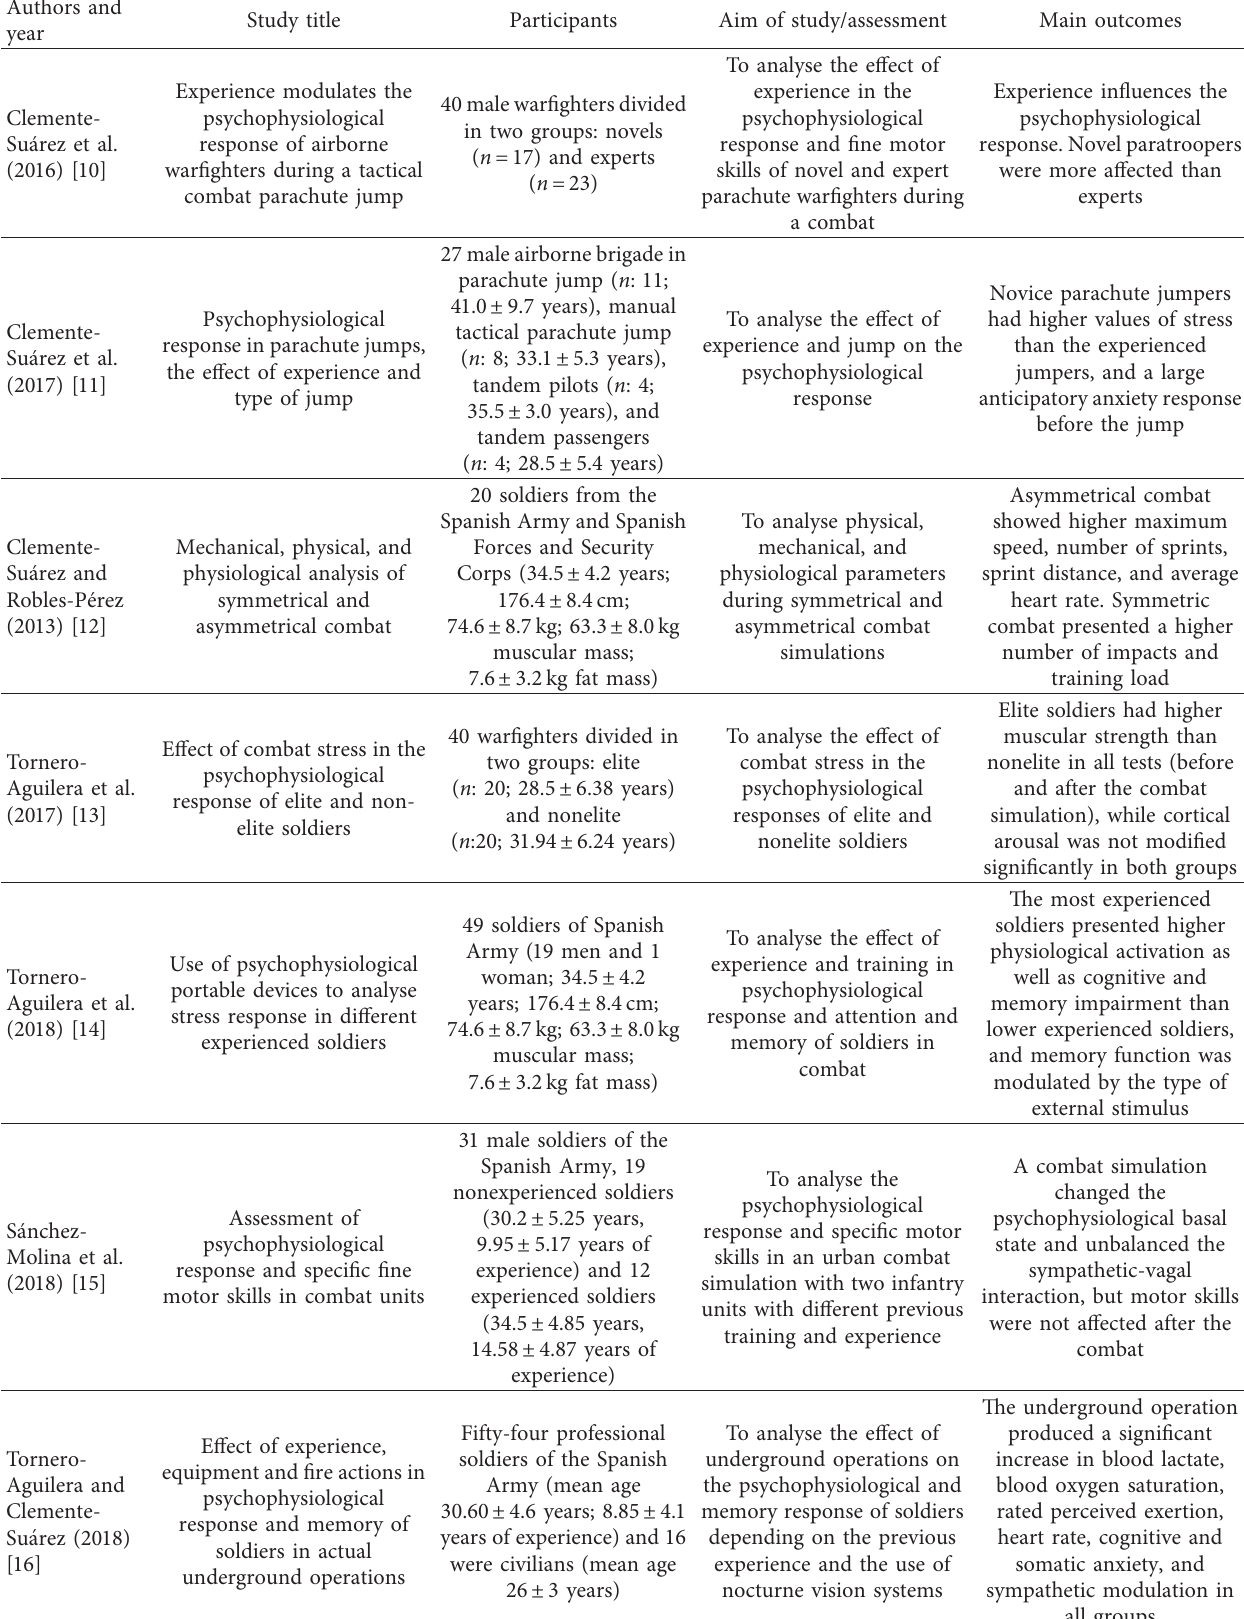
Table 1: Summary of articles about stress response in military